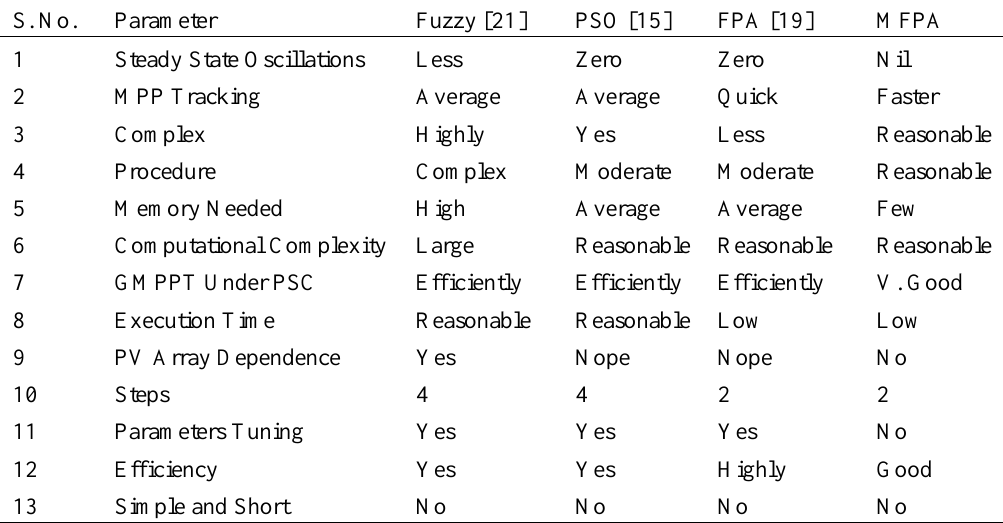
Benchmarks Based Analysis of the Proposed MFPA algorithm S.